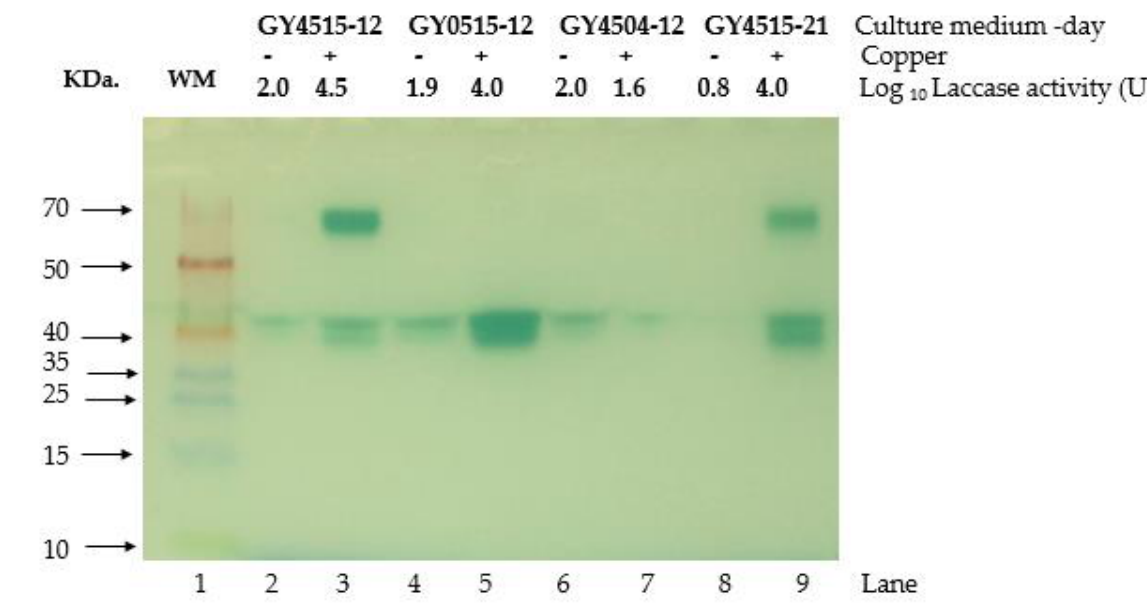
Figure 8. Zymogram of laccases in the supernatant in culture media with different nutrient conditions at 12 or 21 days of culture. Lane 1. Molecular weight marker (WM). Left to right: Lane 2–3 nutrient-sufficient condition GY4515 day 12 (GY4515); Lane 4–5 carbon-limited condition GY0515 day 12 (GY515); Lane 6–7 nitrogen-limited condition GY4504 day 12 (GY4504); Lane 8–9 nutrient-sufficient condition GY4515 day 21 (GY4515-21). Medium without copper ( − ), with copper (+). Laccase activity is presented as log 10 (UL − 1